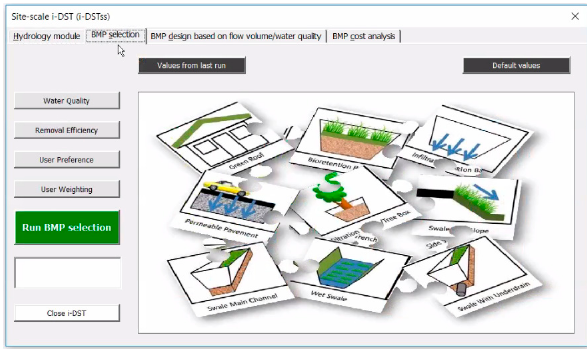
Figure A10. BMP selection module